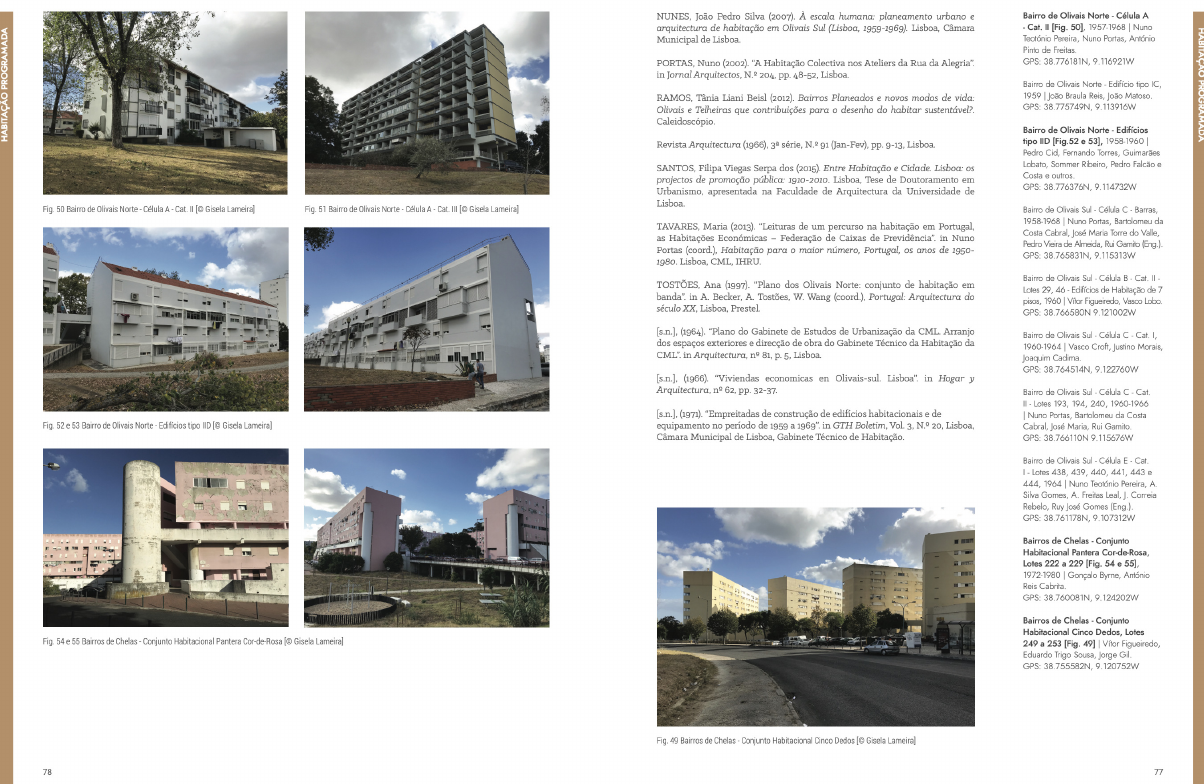
Figure 6. Neighbourhoods of Olivais Norte and Chelas: General views (Plan for Constructing New Housing, 1959). Notes: This double‐page spread shows the neighbourhoods of Olivais Norte (buildings type IID, 1958–1960, reference a188 in MdH database) and Chelas (Pantera Cor‐de‐Rosa housing complex, 1972–1980, reference a534 in MdH database, and